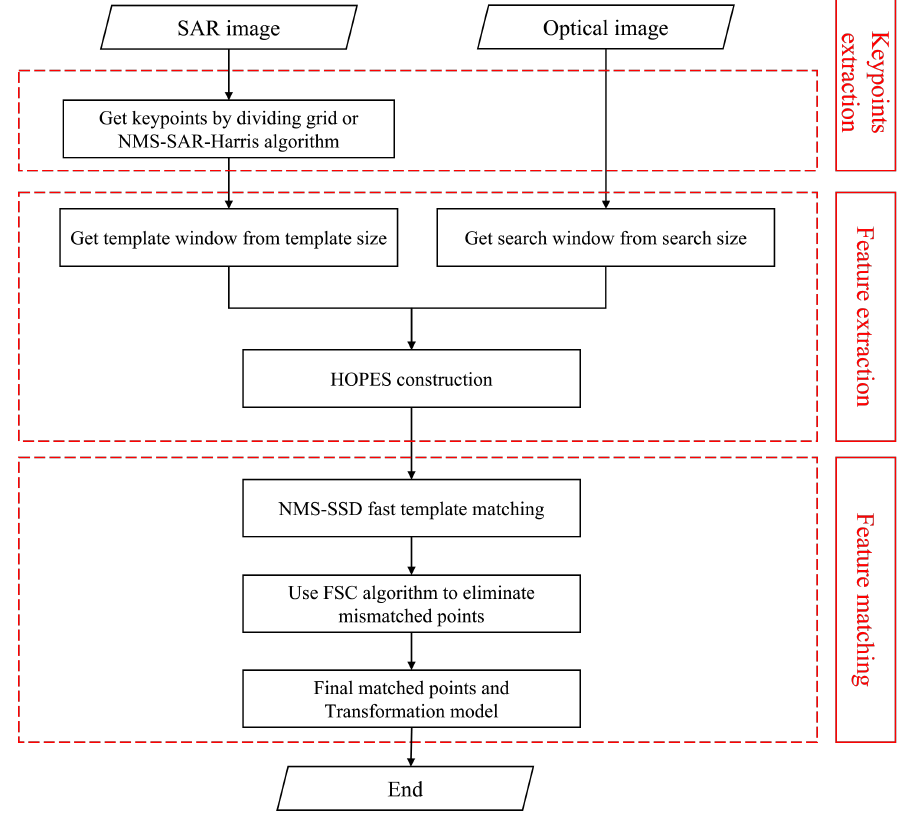
Figure 8. Flowchart of proposed match